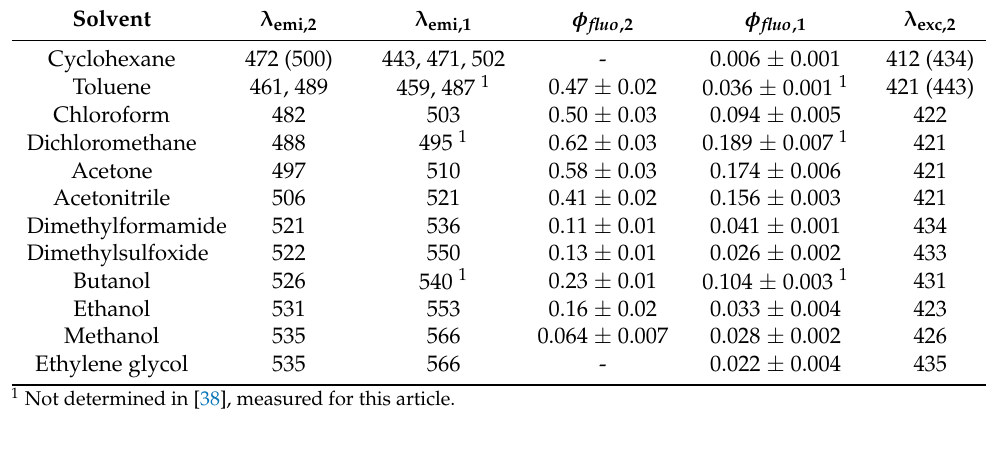
Table 3. Emission peak wavelength, λ 2 in the emi, 2 , and the fluorescence quantum yield, φ fluo , 2 , of different solvents of Table 1 are compared to those of 1 , λ emi, 1 and φ fluo , 1 , reproduced from [38] for the sake of straightforward comparison. The peak excitation wavelength of 2 , λ exc, 2 , is also reported.